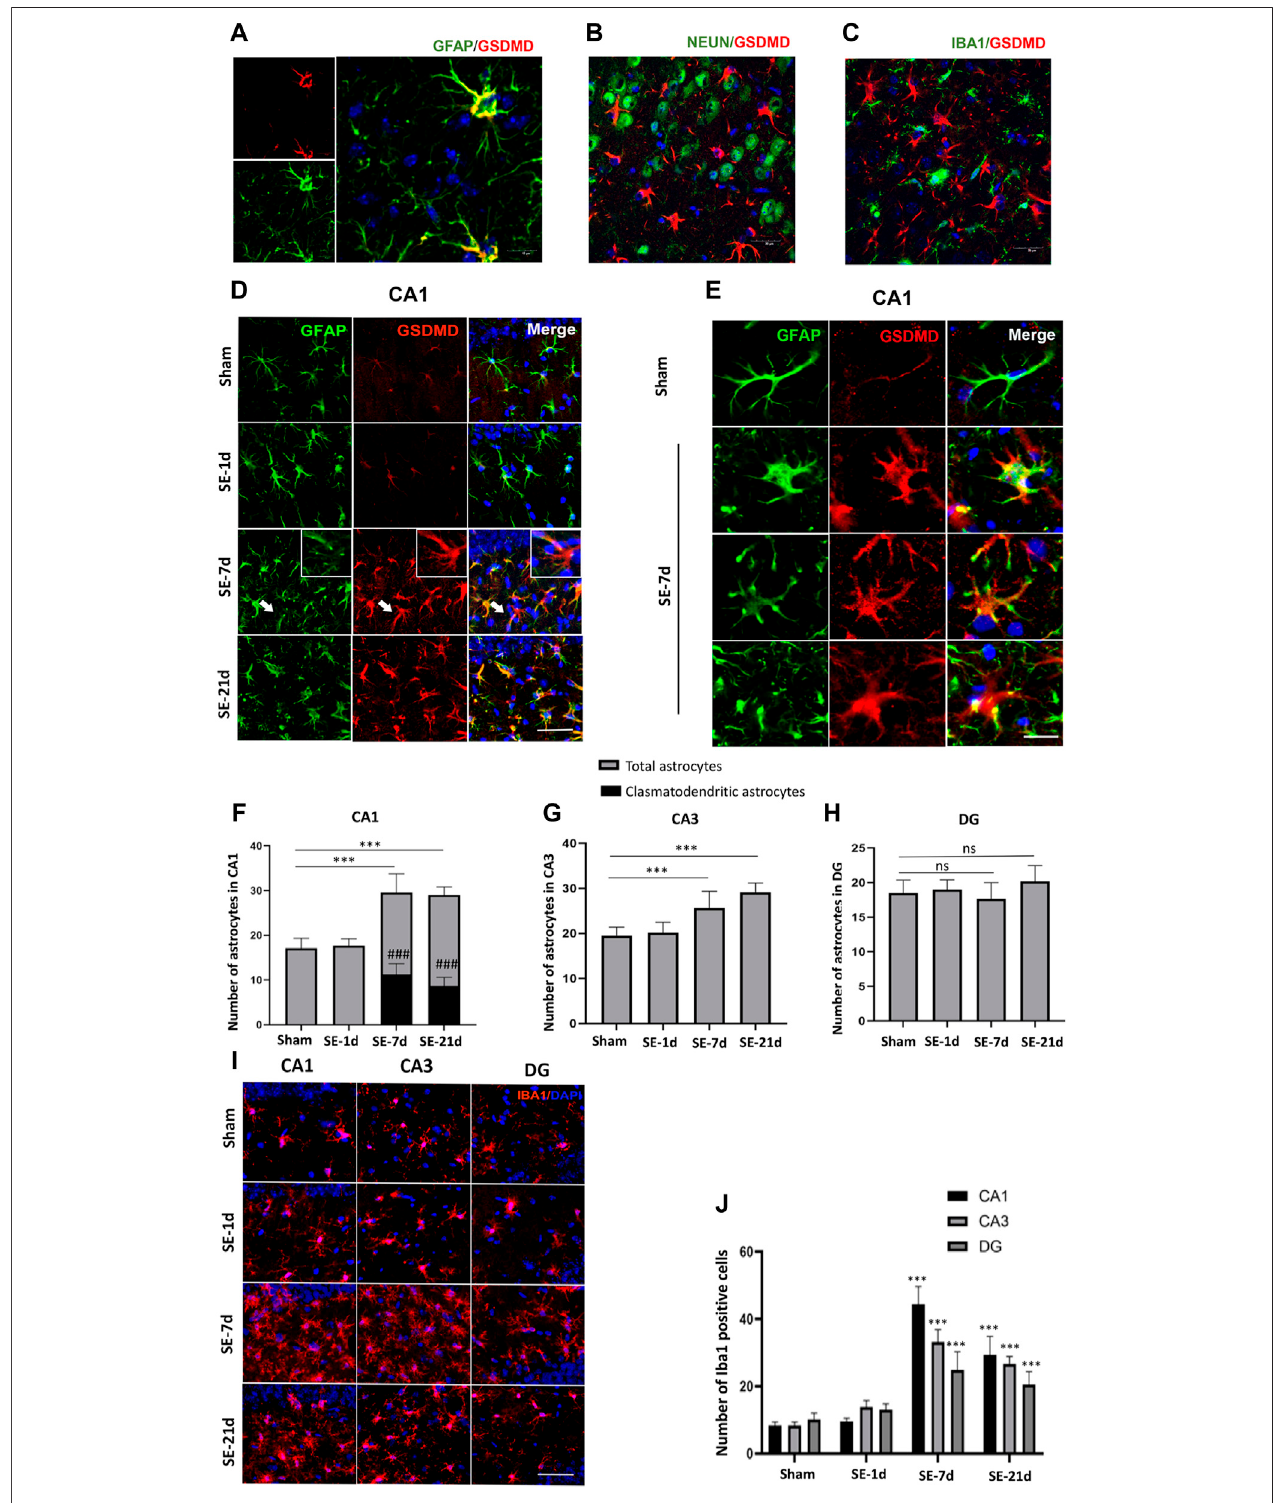
FIGURE 2 | Clasmatodendritic astrocytes co-labeled with GSDMD after SE. (A – C) Representative images of GSDMD (red)/GFAP (green), GSDMD (red)/NeuN (green), and GSDMD (red)/Iba-1 (green) staining in hippocampal slices from mice at day 7 after kainic acid injection. (D) Microphotographs of GSDMD (red) and GFAP (green) staining in the CA1 region of the hippocampus in the sham, SE-1d, SE-7d, and SE-21d groups (bar (cid:1) 50 µm). (E) Typical GSDMD-positive clasmatodendritic